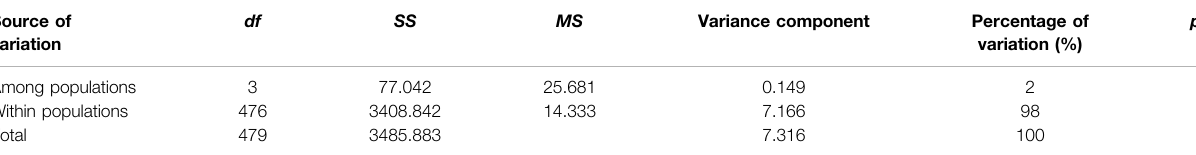
TABLE 6 | Analysis of molecular variance (AMOVA) from four P. trituberculatus populations.